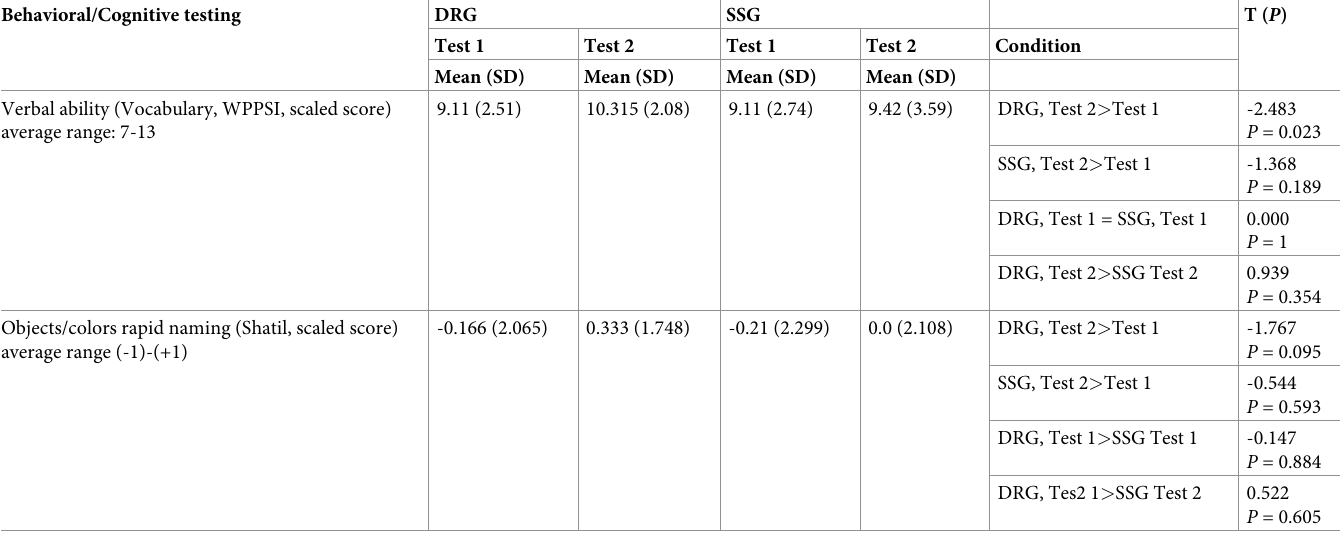
Table 2. Effect of intervention in dialogic reading and screen story intervention groups on linguistic measures. Behavioral/Cognitive testing